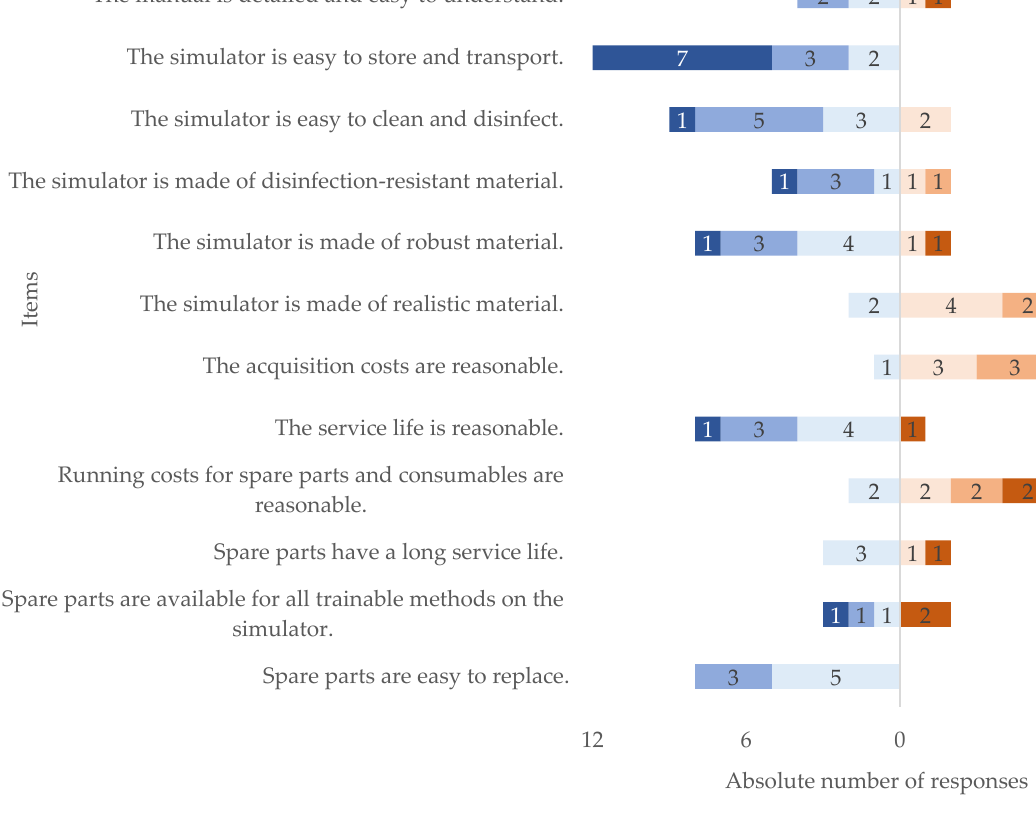
Figure 4. Descriptive analysis of the practical satisfaction with rat simulator type B. Distribution of replies on the practi- cability of rat simulator B for multiple use on a six-point Likert scale, referring to the most frequently performed course type. Data are shown in a diverging stacked bar chart. Statements about practicability are listed on the y-axis, response frequencies on the x-axis, ranging from “1: fully applies” (dark blue), “2: largely applies” (blue), “3: rather applies” (light blue) on left- to “4: rather does not apply” (light red), “5: largely does not apply” (red), “6: does not apply at all” (dark red) on the right-handed diverging stacked bars. Absolute number of responses is shown for each statement in the corresponding bar ( n = 12).